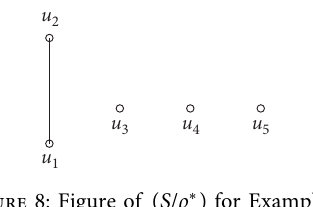
Figure 8: Figure of ( S / ρ ∗ ) for Example